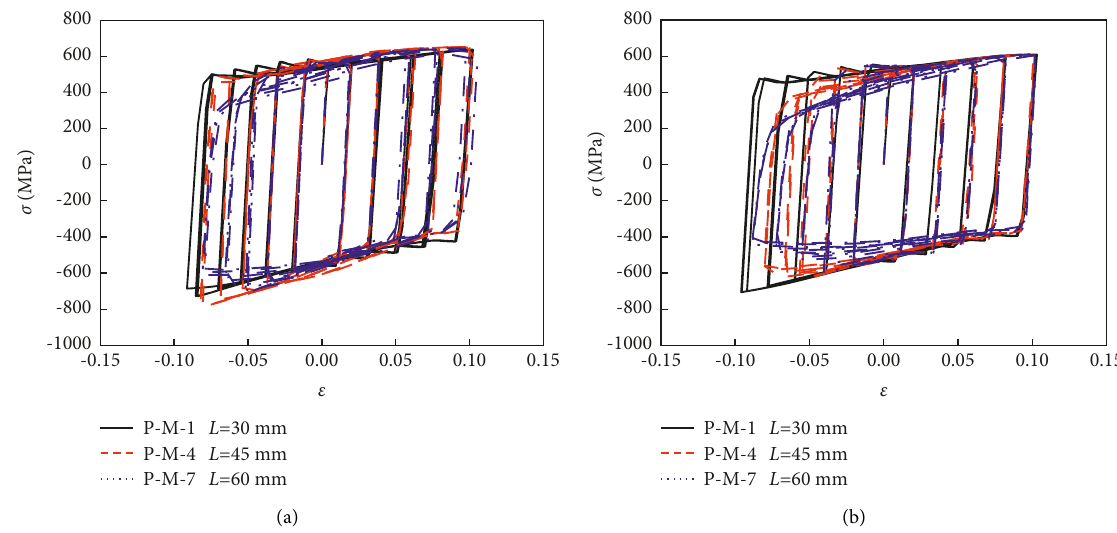
Figure 16: Hysteresis curves of material specimens with different parallel lengths. (a) Hysteresis curves of specimens in group P-M. (b) Hysteresis curves of specimens in group